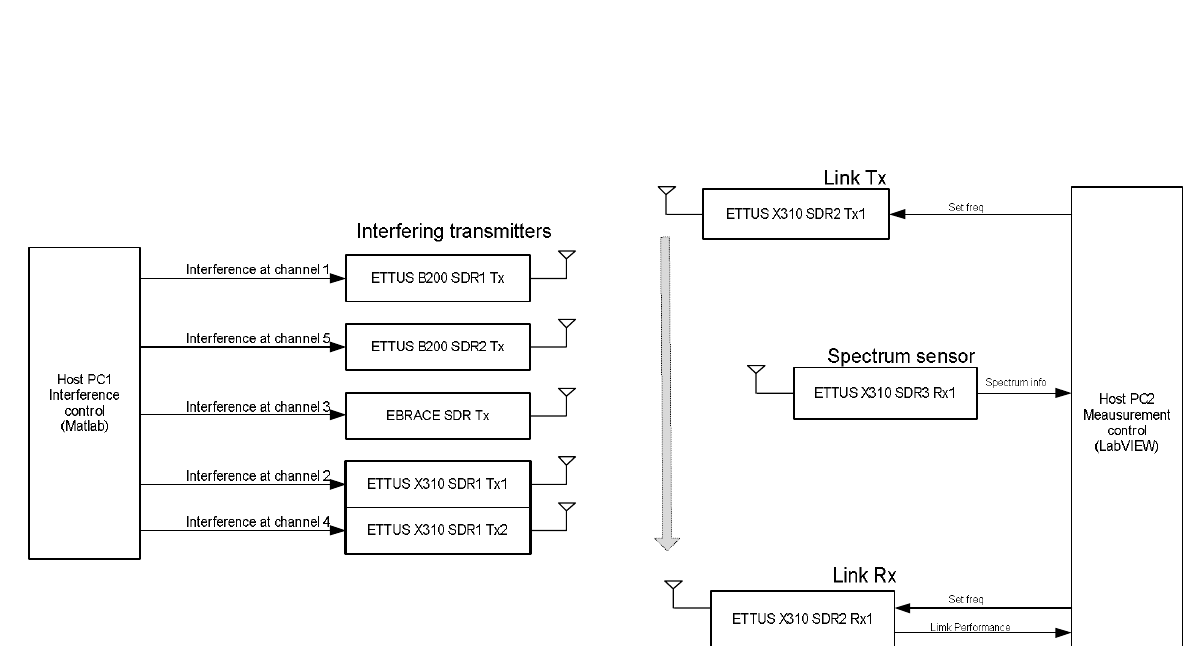
Figure 3. Block diagram of the measurement setup.